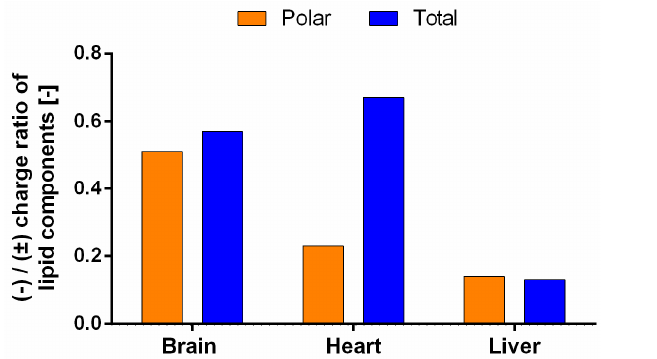
Figure 5. Charge ratio of net negative and net neutral known lipid components in tissue specific lipid extracts at pH 7.4 (Values of charge ratio: BPLE: 0.51, BTLE 0.57:, HPLE: 0.23, HTLE: 0.67, LPLE: 0.14, and LTLE: 0.13) .